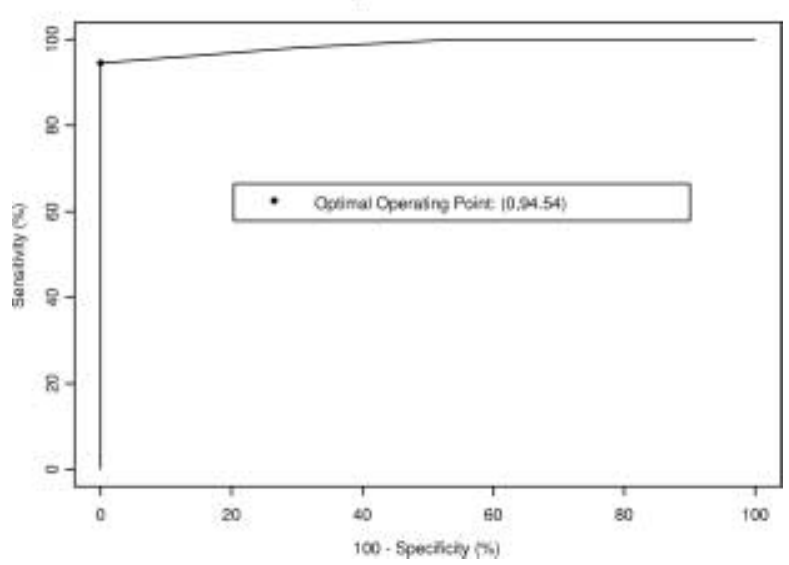
Fig. 1. This plot shows the ROC curve for the PIV2.12 score. The solid diamond shows the operating point with the optimal sensitivity and specificity in terms of their sum.